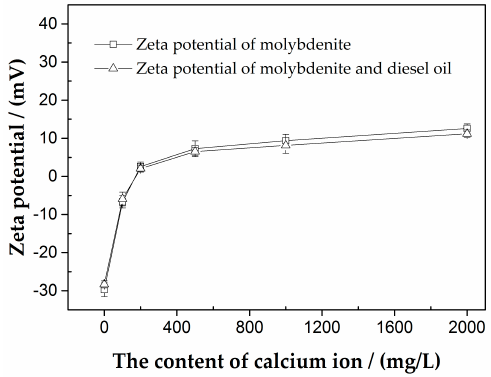
Figure 5. The zeta potential of molybdenite below 38 µ m as a function of Ca 2+ concentration in the absence and presence of 20 mg/L diesel at pH